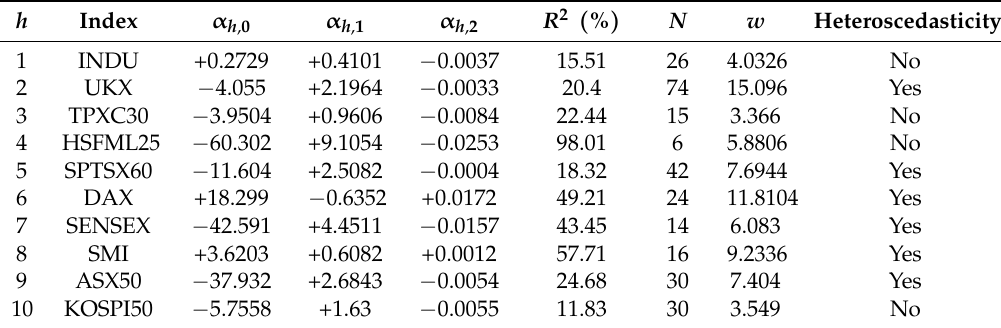
Table C1. White Test for Heteroscedasticity (95.0%) original data: 2005–2014.